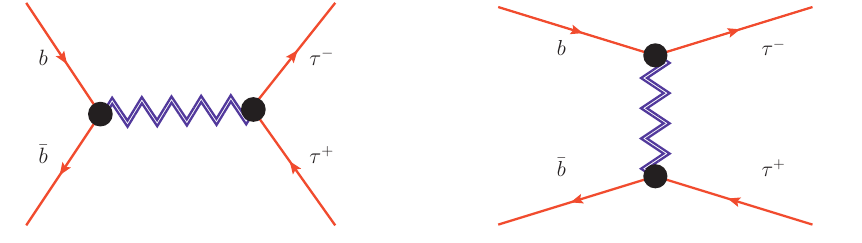
Figure 2: Diagrammatic representations of NP contributions to b ¯ b → τ + τ − at the LHC. (left) s − channel resonant exchange of color-neutral mediators, (right) t − channel non-resonant exchange of